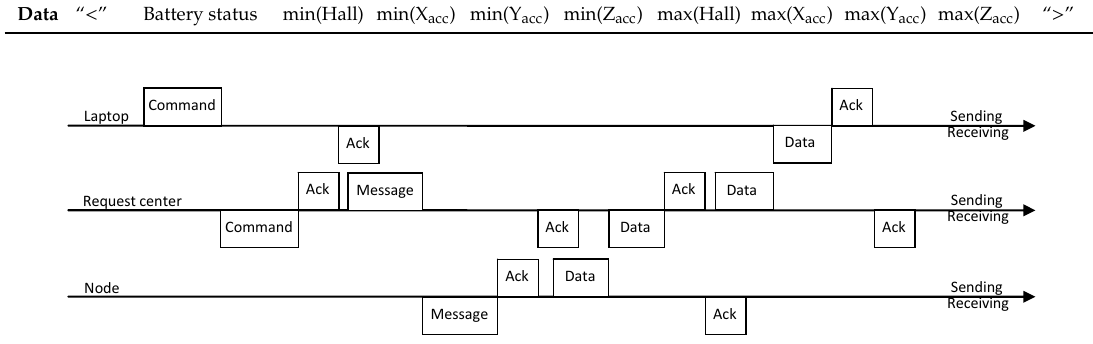
Figure 9. Transmission protocol. Buildings 2020 , 10 , x FOR PEER REVIEW